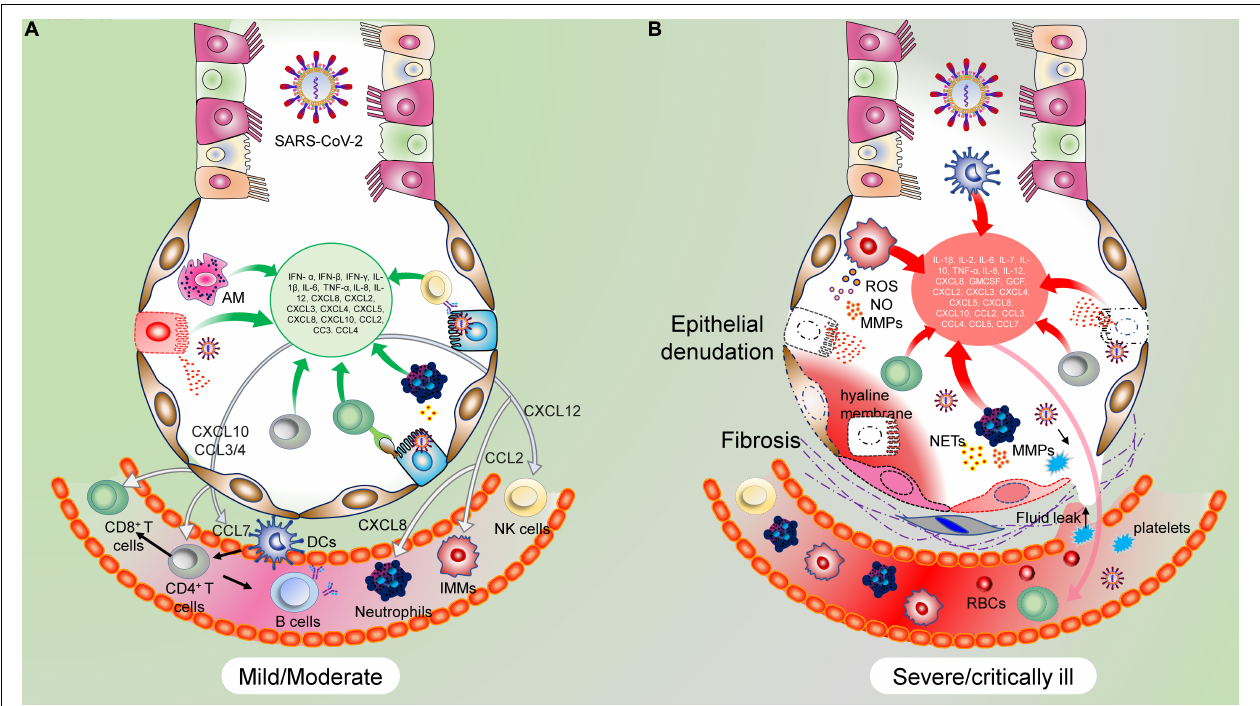
FIGURE 5 | Immunopathological changes during different stages of COVID-19. (A) Immunological response in mild/moderate COVID-19 patients are overtly conferred by the adaptive immune cells with assistance from the innate immune system. Infected ATII cells and activated AMs produce a repertoire of cytokines and chemokines to recruit innate and adaptive immune cells and limit the viral propagation. The functional immune system thus acts in a well-coordinated manner to eliminate the virus specific ATII cells. Due to the relatively stem cell-like property of ATII cells, the eliminated cells are subsequently regenerated, thus ensuring recovery of the damaged lung tissue. (B) However, in severe/critically ill patients, an exaggerated inflammatory response is mounted by hyperactivated innate immune cells, and to a lower degree by adaptive immune cells. A hyperinflammatory state is created in the lungs which is characterized by the robust accumulation of inflammatory cells like monocytes/macrophages, dendritic cells, and neutrophils. This leads to the excessive release of cytokines and chemokines by these cells, thus inducing a vicious hyperinflammatory cycle. Damage to the lung parenchyma is inflicted by this hyperinflammatory state, along with other cytotoxic molecules like MMPs, NETs, ROS and NO. The latter two combine to form more cytotoxic peroxynitrite ions. The combined action of these events results in epithelial denudation, vascular leak, platelet and RBC infiltration, vascular edema, and hyaline membrane formation, resulting in